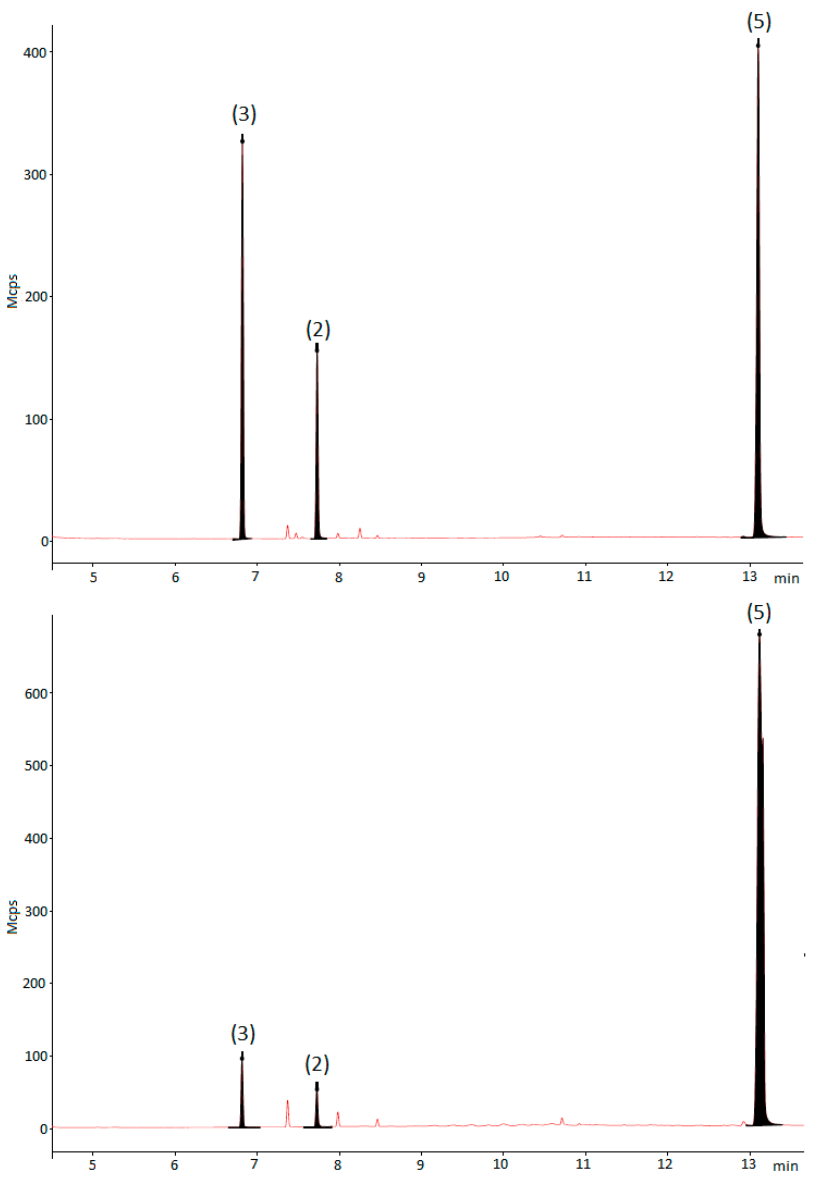
Figure 4. Effect of the reaction workup over the crude composition. Compound notation: (3) glyceraldehyde diacetate, (2) 1,2-diacetin, and (5) 3-((2,3-diacetoxypropanoyl)oxy)propane-1,2-diyl diacetate. Top: GC analysis of the reaction crude performed before the reaction workup. Bottom: GC analysis performed after the reaction’s crude filtration through a silica pad.